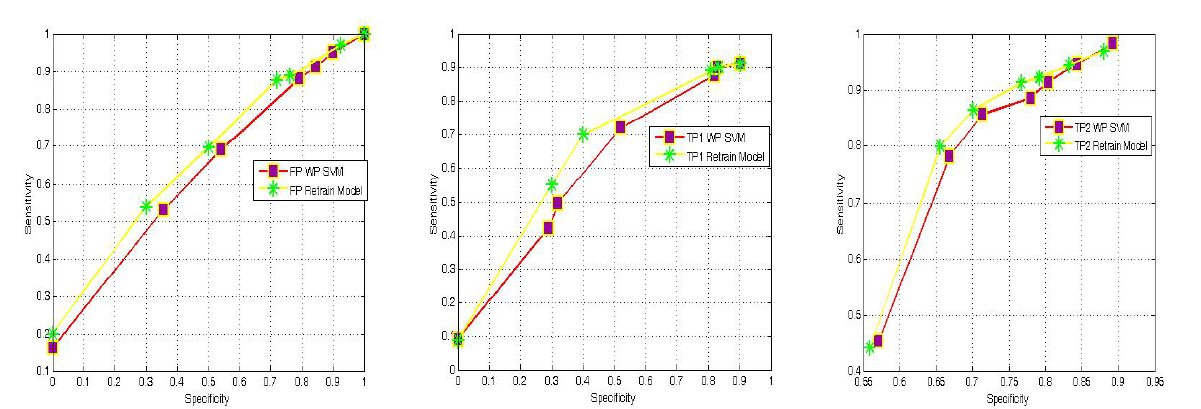
Figure 5. FP, TP2 and TP1 ROC Curves for Retrain_Model and Inc_Model .